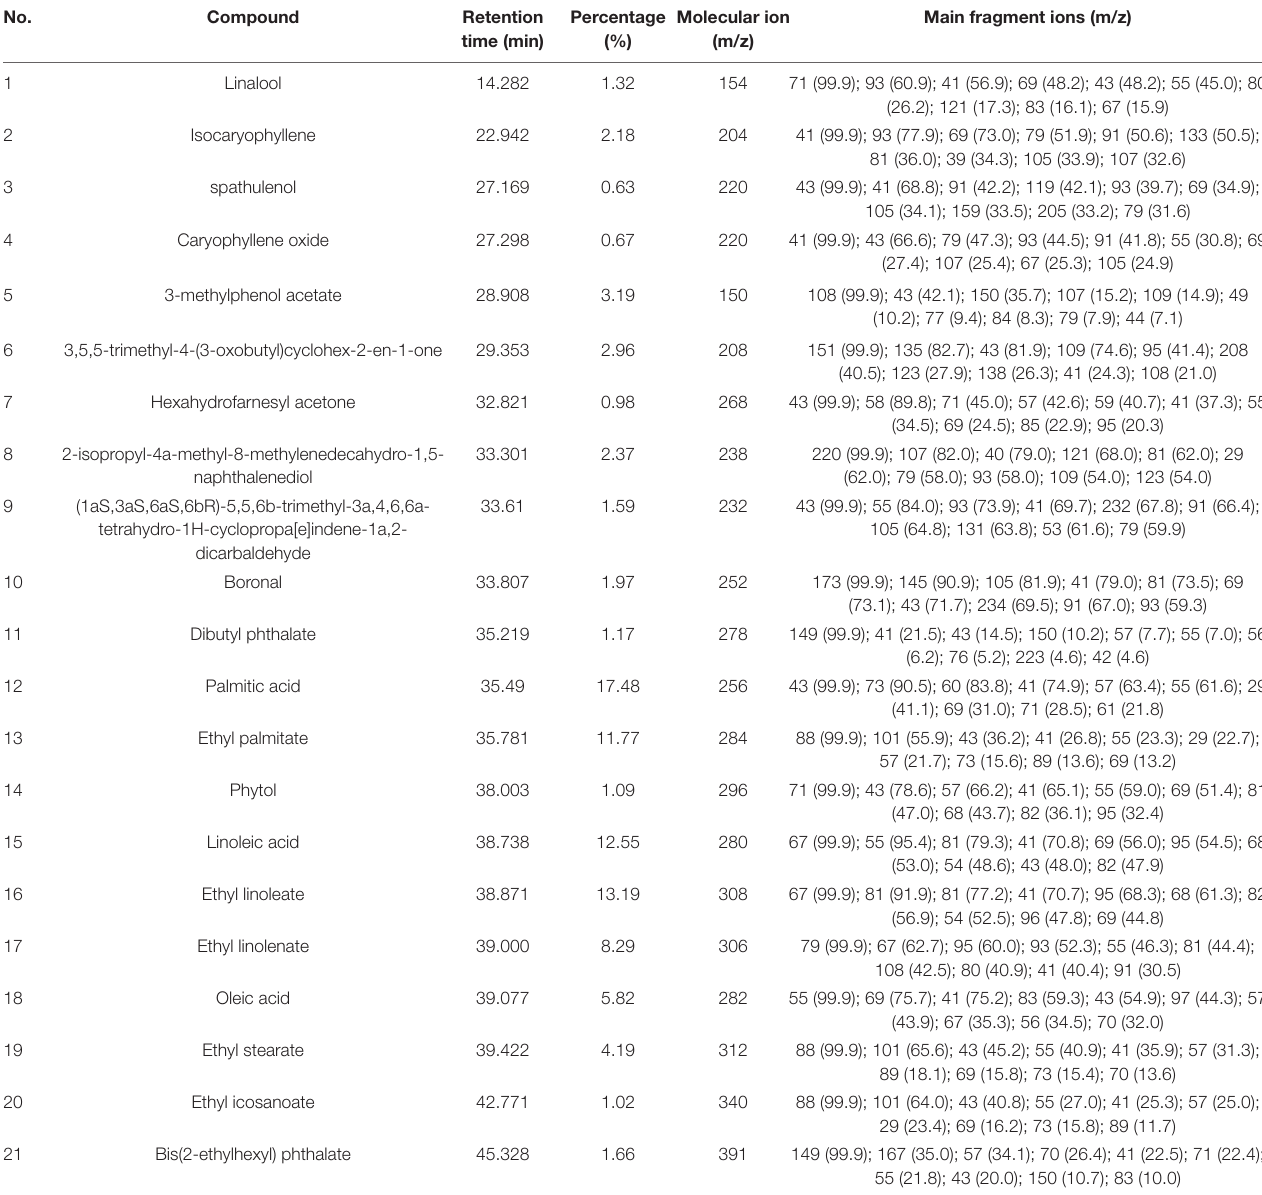
TABLE 1 | Chemical compounds of sweet potato petroleum ether